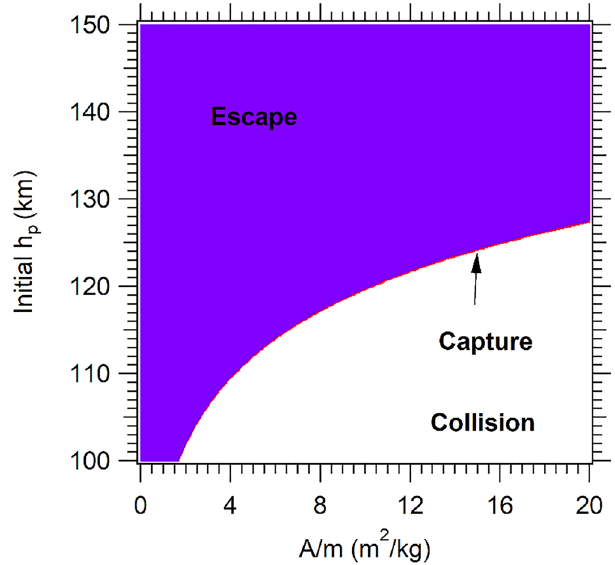
Figure 3. Final trajectories for V P = 1.89 VU, retrograde direction.